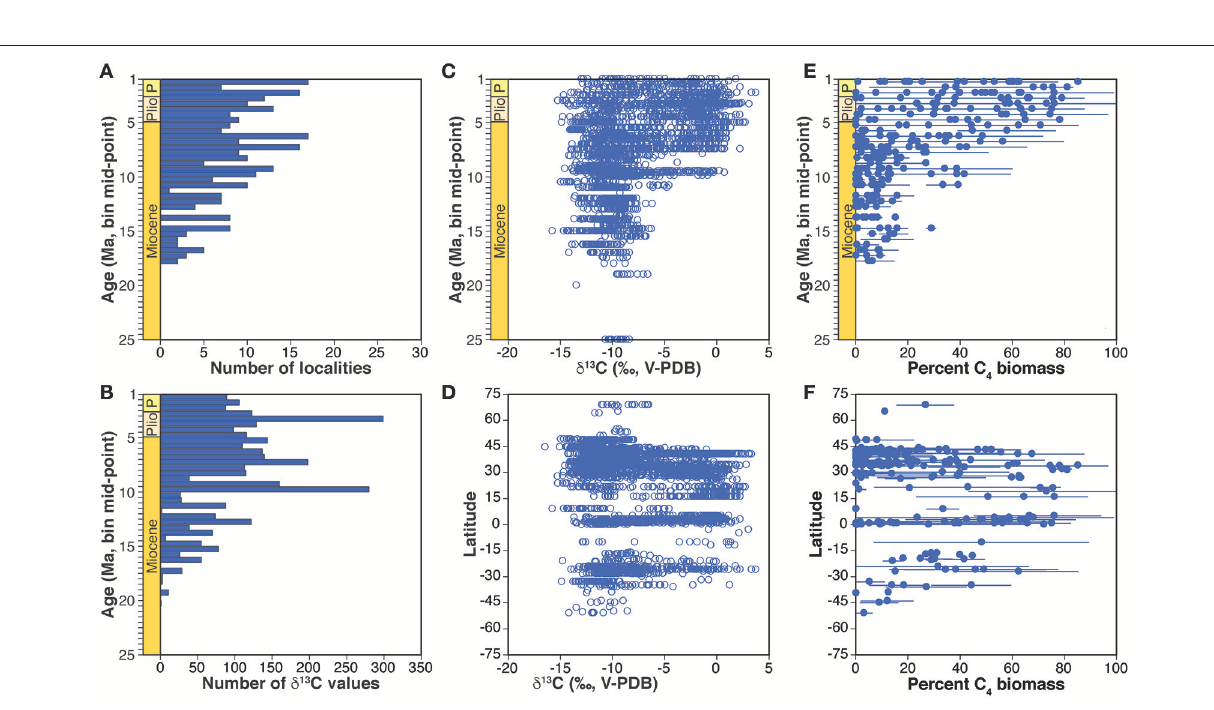
FIGURE 2 | Summary of the compilation of paleosol carbonate δ 13 C values. Number of localities (A) and δ 13 C values (B) in each 0.5 Myr bin. All δ 13 C values by mid-point of 0.5 Myr age bin (C) and by latitude of sample site (D) . Mean and standard deviation of estimated percent C 4 biomass for each locality by midpoint of 0.5 Myr age bin (E) and by latitude of site (F) .